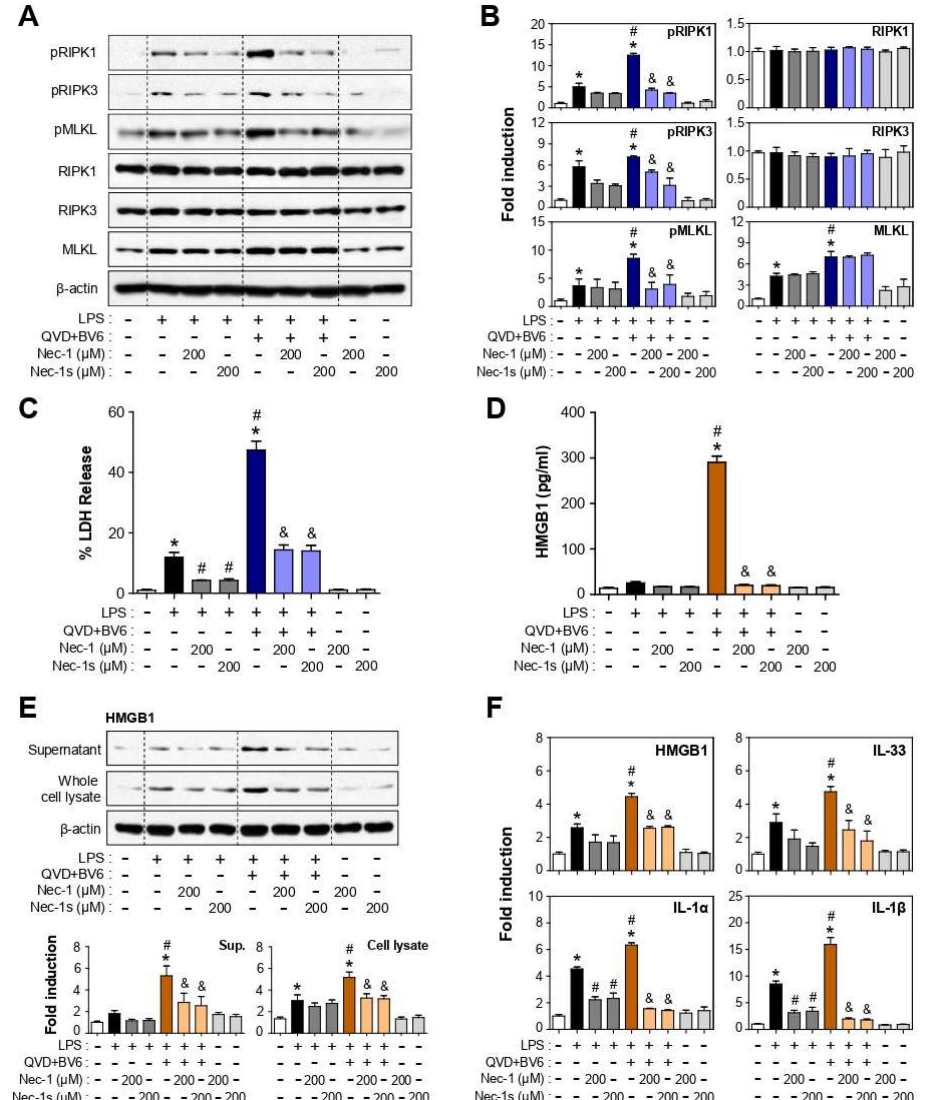
Figure 2. Effect of Nec-1/Nec1-s on the phosphorylation of RIPK1-RIPK3-MLKL, cell death, and the expression of DAMPs in LPS and LPS/QVD/BV6-stimulated BV2 cells. ( A , B ) Cell lysates were obtained from LPS or LPS/QVD/BV6-treated cells in the absence or presence of Nec-1/Nec-1s for 8.5 h and analyzed by Western blot for expression of phospho- and total form of RIPK1, RIPK3, MLKL. Representative gels are shown in the left panel, and the quantification of three experiments is shown in the right panel. ( C , D ) Culture supernatants were collected from aforementioned treated cells to determine the level of LDH ( C ) and HMGB1 ( D ) release. ( E ) Western blot data showing the effect of Nec-1/Nec-1s on HMGB1 protein expression in cell lysates and supernatant. ( F ) Quantitative real-time PCR data showing the effect of Nec-1/Nec-1s on mRNA expression of DAMPs; HMGB1, IL-1α, IL-1β, IL-33. All data are shown as the mean value ± SEM of three independent experiments. * p < 0.05 vs. control; # p < 0.05 vs. LPS-treated samples; & p < 0.05 vs. LPS/QVD/BV6-treated samples.